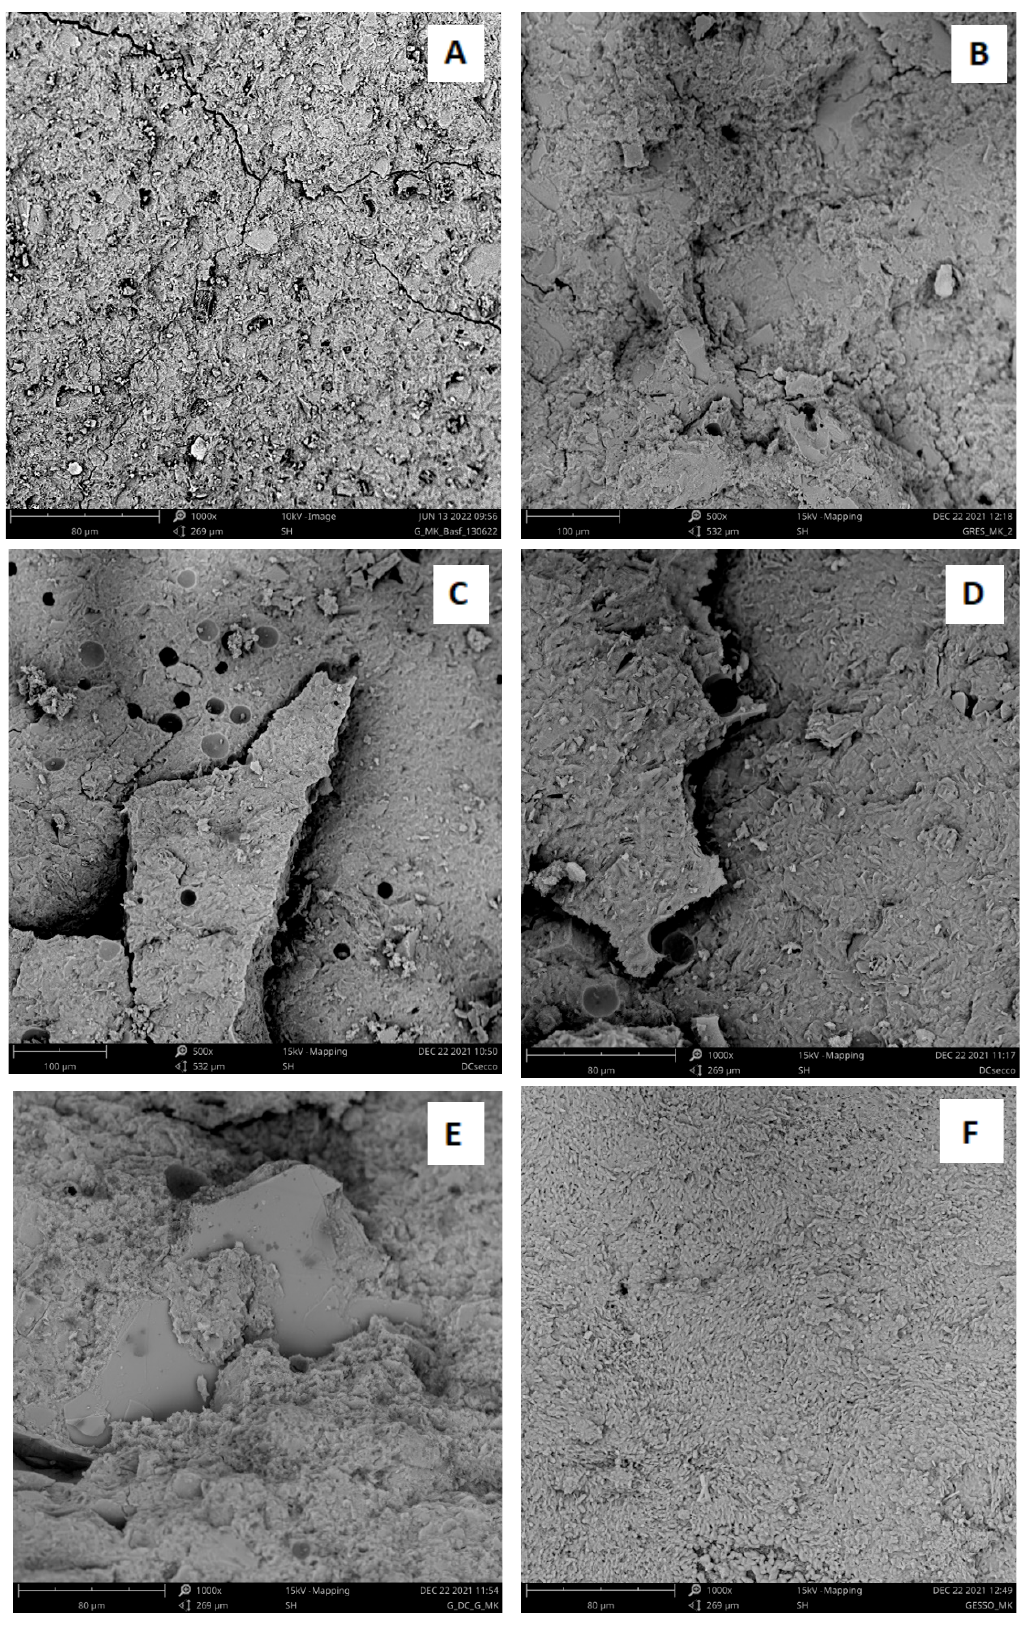
Figure 4. Scanning Electron Microscope (SEM) images of ( A ) neat geopolymer; ( B ) PS-MK; ( C ) RP-MK; ( D ) RP dry -MK; ( E ) MIX-MK; and ( F ) Gy-MK mortars at 1000× magnifications.